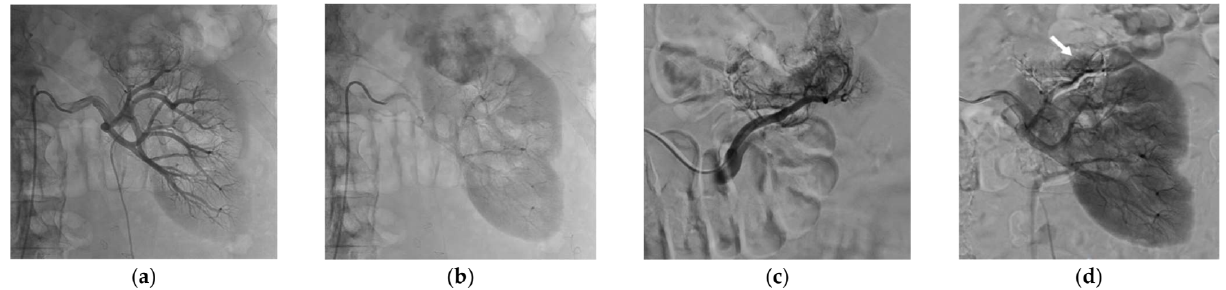
Figure 2. Selective arterial embolization (SAE) procedure using NBCA/Lipiodol ® mixture performed before percutaneous cryoablation of a renal cell carcinoma of the upper pole of the left kidney. ( a , b ) Angiogram showed hypervascularrenal malignancy. ( c ) Selective angiogram after embolization of a feeding artery of the tumor showing another feeding artery with residual tumor blush. ( d ) Control angiogram showing the occlusion of the two major feeding arteries after embolization with a small residual tumor blush (white arrow).